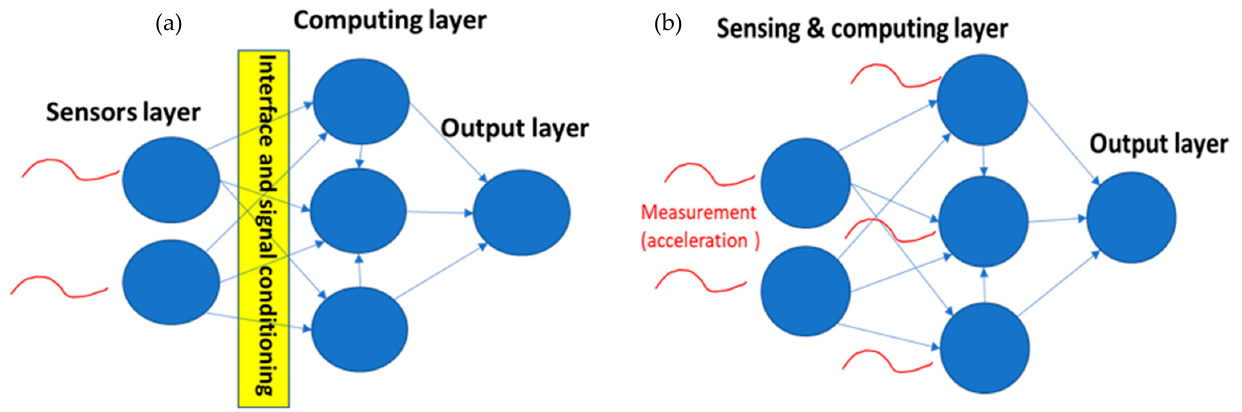
Figure 3. ( a ) Our previous attempt for building a MEMS CTRNN follows a typical machine learning approach that separates sensing and computing. While it provides an efficient way to do computing, it still requires the complex sensor reading and interface between the input and output layers. ( b ) This paper’s contribution is to investigate and demonstrate a MEMS CTRNN that no longer separates between the input and output layers.